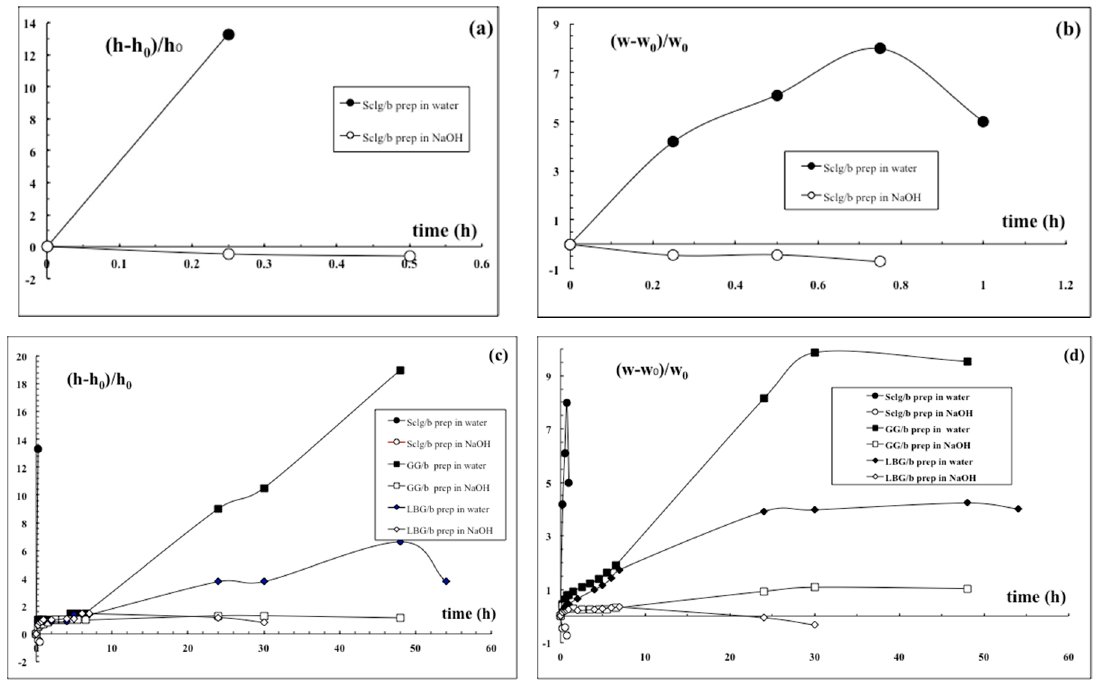
Figure 2. Relative increase of tablet heights for Sclg/borax ( a ); Sclg/borax, GG/borax, and LBG/borax ( c ); tablet water uptake for Sclg/borax ( b ); Sclg/borax, GG/borax, and LBG/borax ( d ). (Full symbols: tablets prepared in water and swelled at pH = 14; empty symbols: tablets prepared at pH = 14 and swelled in water. T = 37 °C).